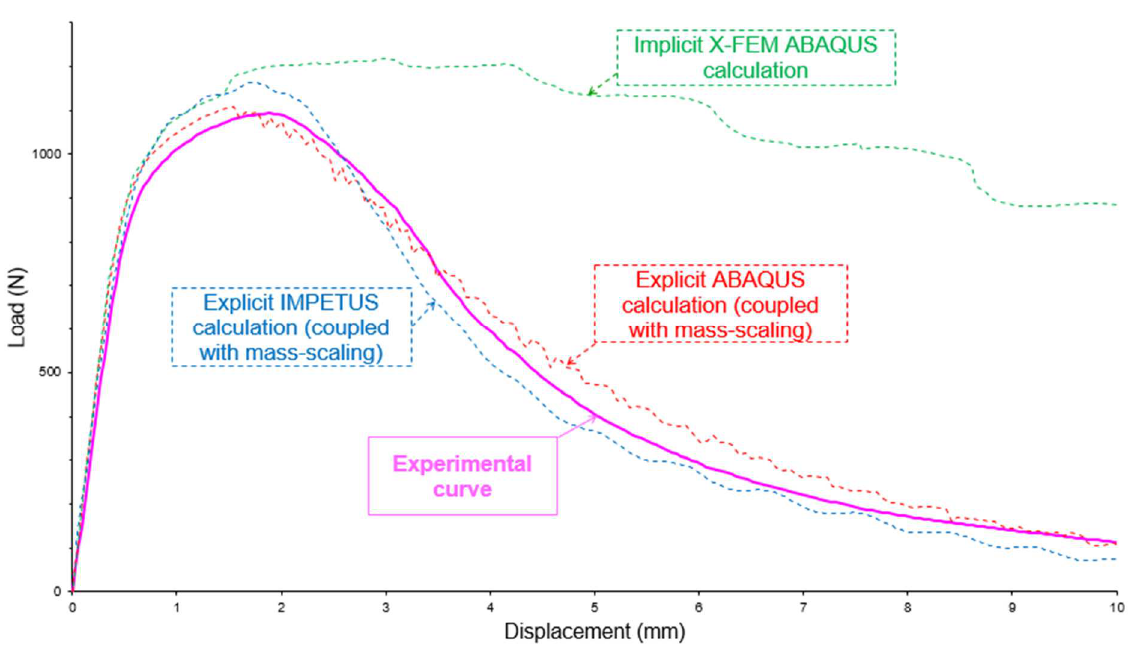
Fig. 8. Load versus displacement of the cross head for experimental and computing